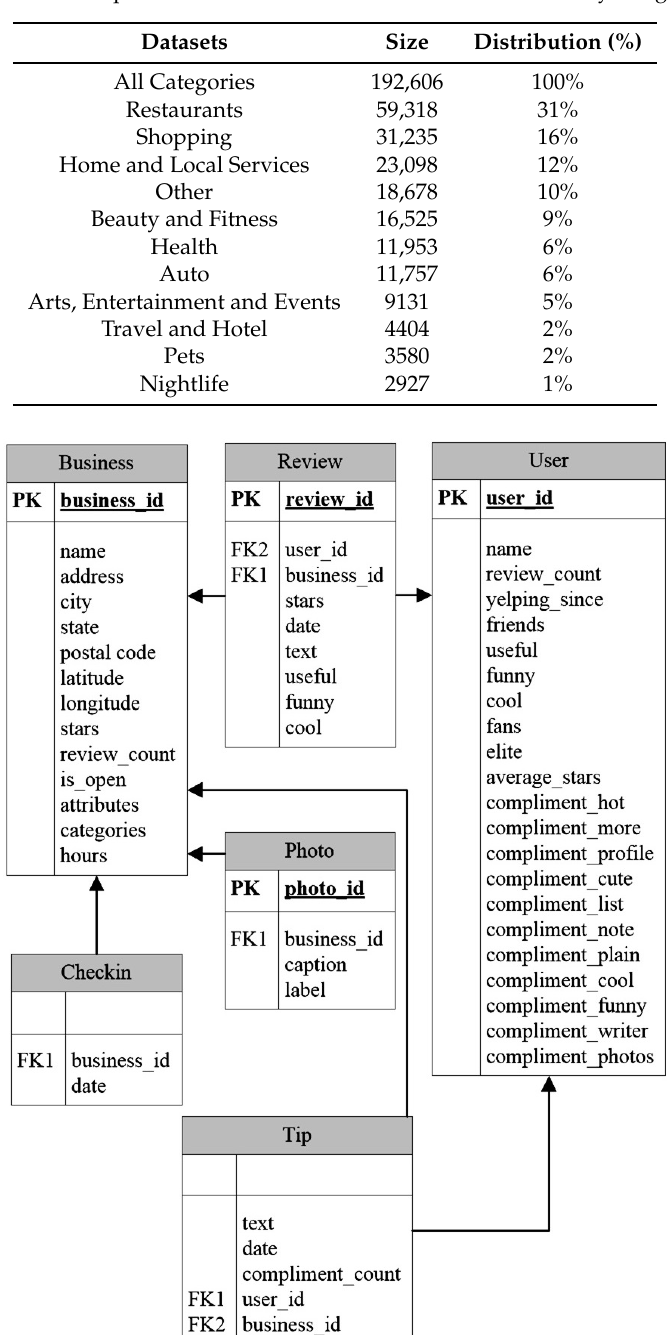
Table 1. Description of datasets and distribution of businesses by category.